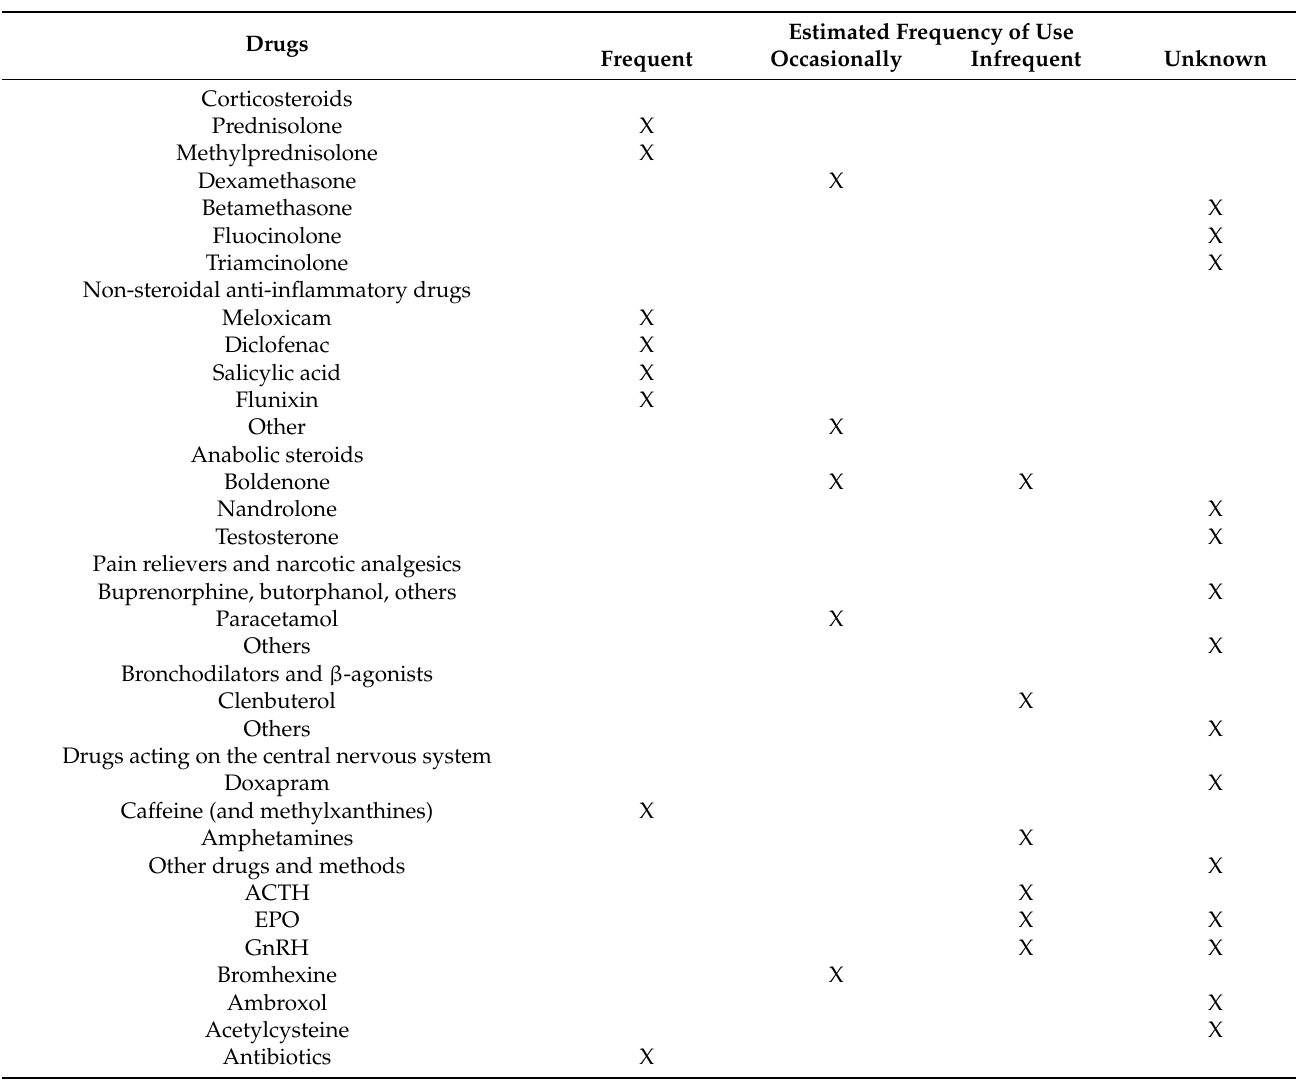
Table 1. Estimated frequency of use of substances potentially administered by pigeon fanciers with the aim of influencing the sporting performances of carrier pigeons based on confidential field reports or direct observations (D. Marlier) or unpublished confidential results of a survey conducted in 2017 in Belgium [39]. This table should be taken with caution and is only indicative as it is not based on published and peer reviewed